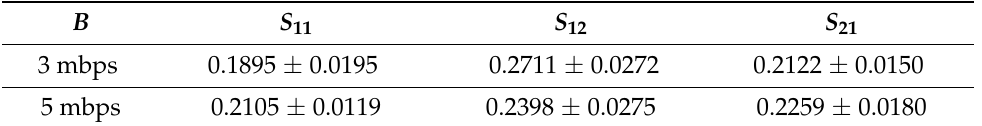
Table 3. The average unfairness index F of the general ABR.